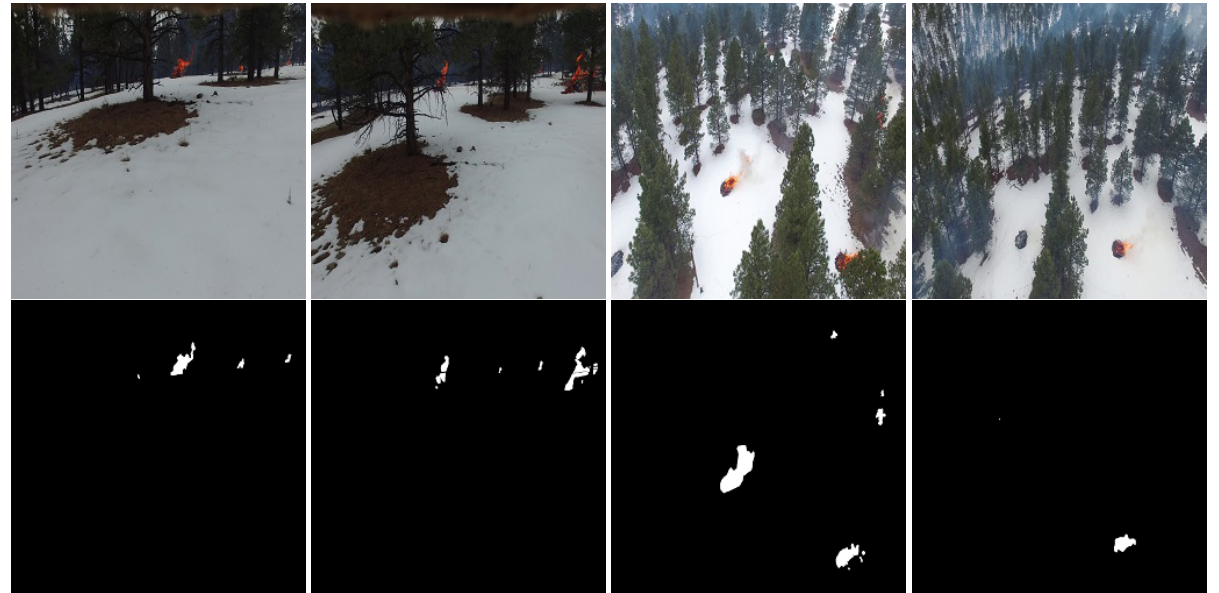
Figure 7. Samples of the FLAME dataset. ( Top ): RGB aerial images; ( Bottom ): their corresponding binary